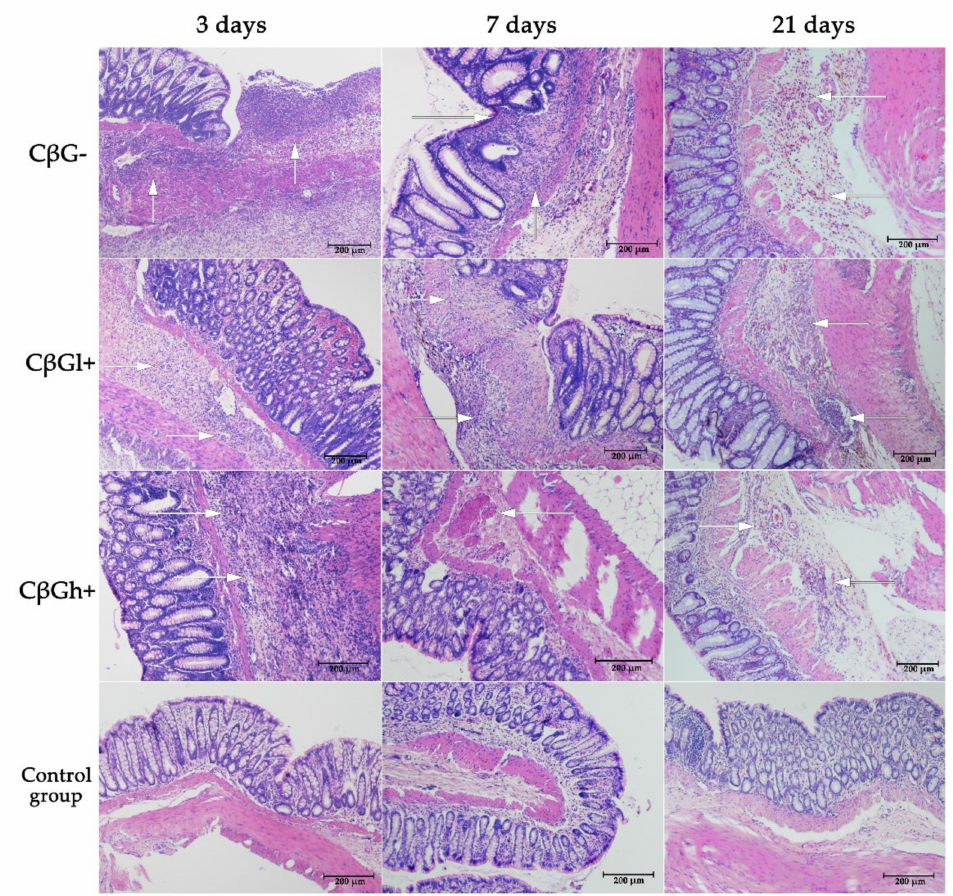
Figure 2. Microscopic changes in the colon caused by TNBS-induced inflammation. White ar- rows indicate diffused multifocal inflammation (lymphocyte infiltration) of the submucosa of varying